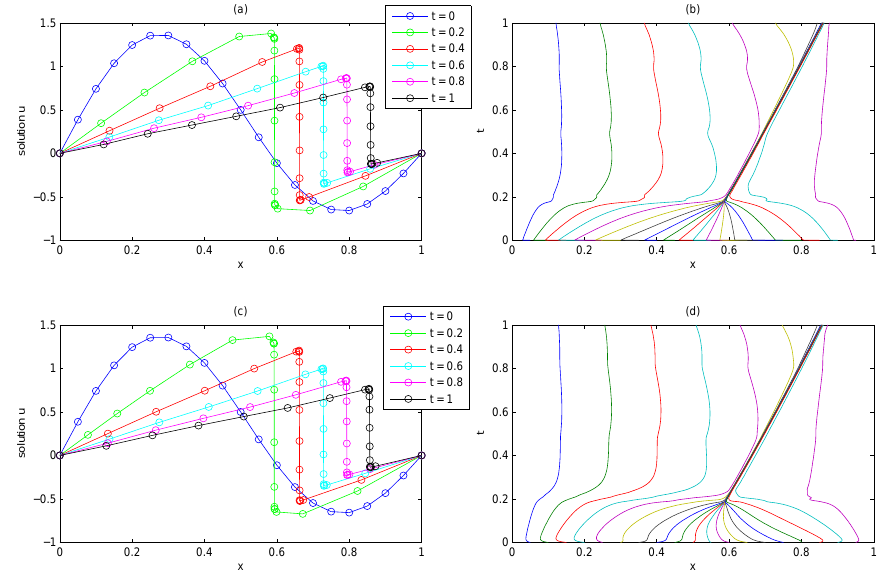
Figure 3. Numerical solutions and trajectories of the Burgers equation with n = 1 applying Huang’s method ( a , b ) and the proposed method ( c , d ).